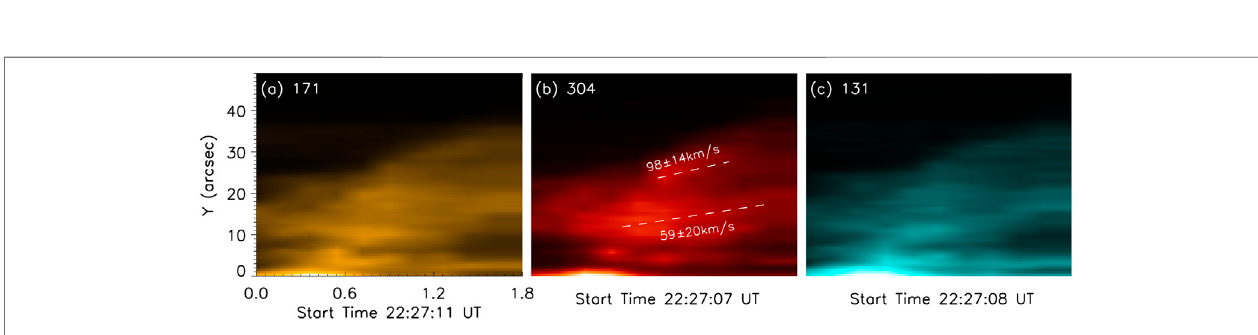
FIGURE 6 | Time-distance plots of the blobs along the jet shown in Figure 4B at three different wavelengths: 171Å, 304 Å and 131 Å.